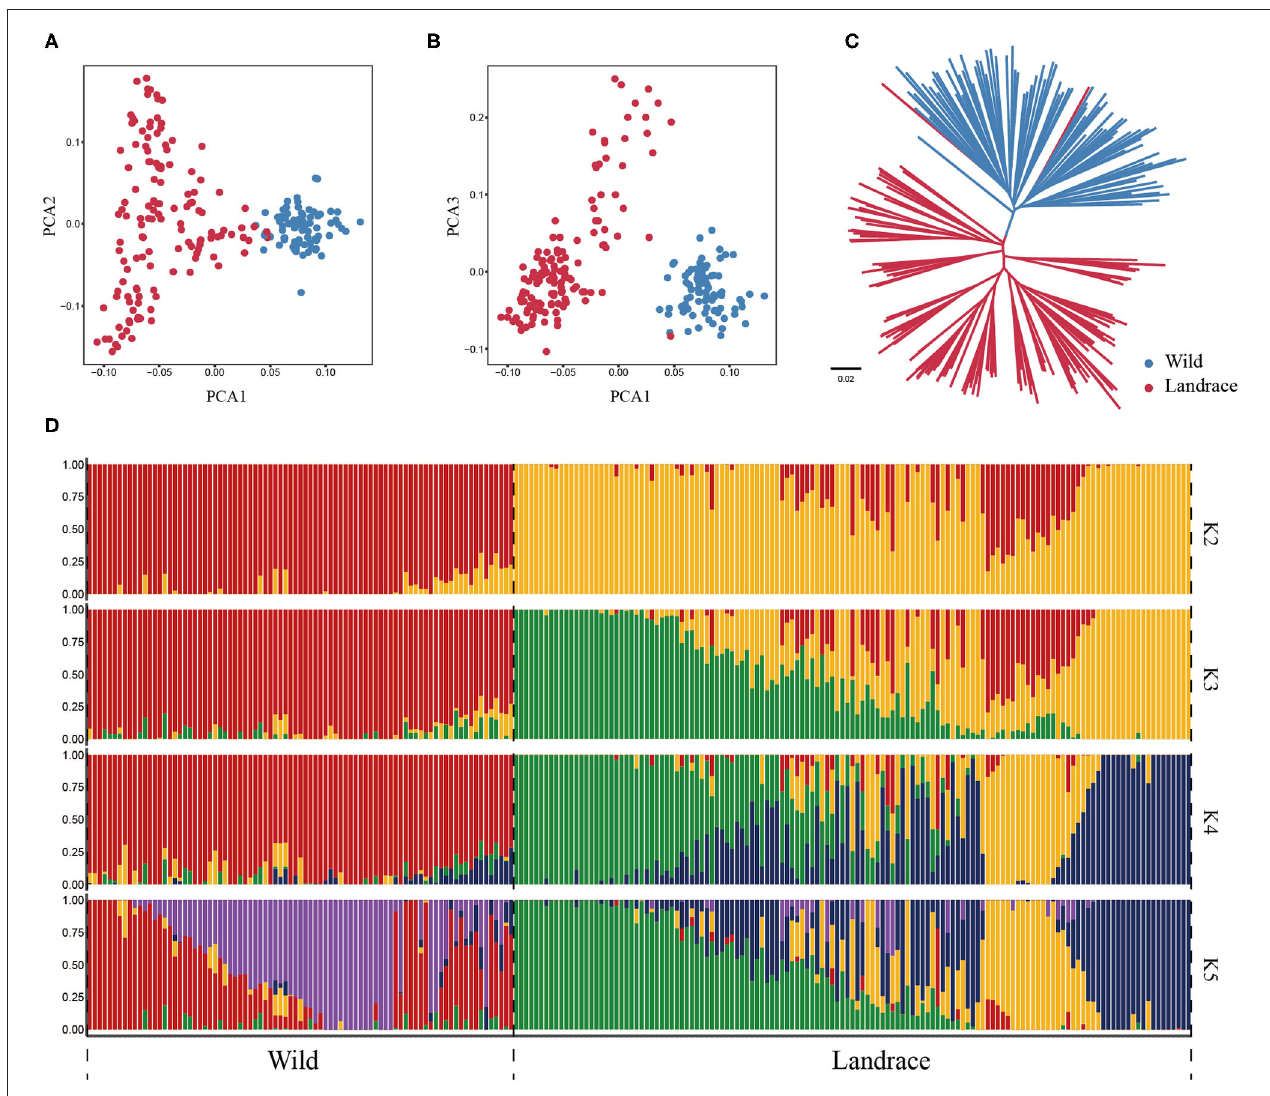
FIGURE 8 | Population structure of wild barley accessions and landraces based on HvmTERF -related SNPs. (A) Principal component analysis PC1 vs. PC2, (B) Principal component analysis PC1 vs. PC3, (C) The NJ phylogenetic tree, (D) Population structure with K ranging from 2 to 5.